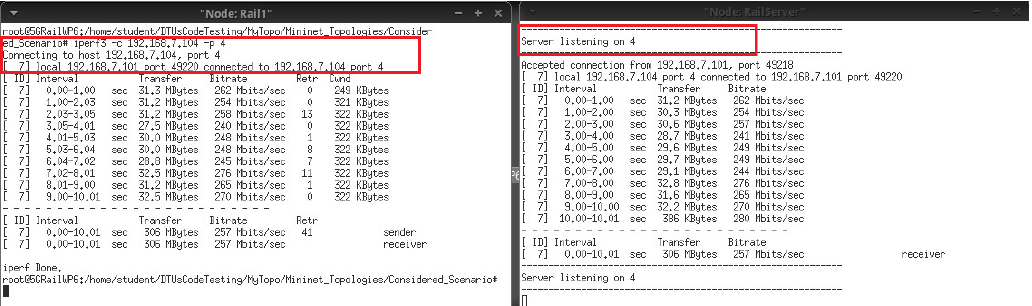
Figure 24. UDP data transmission from Train1 to RailServer.